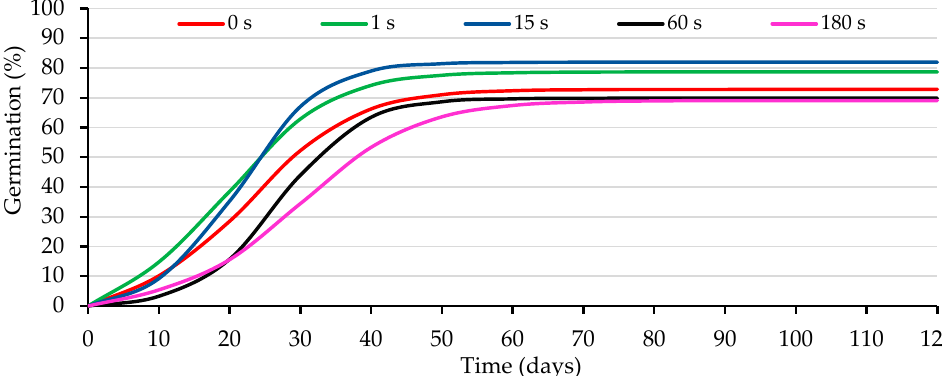
Figure 3. Logistic model adjusted to the curves of accumulated germination of caper seeds from Experiment 3. Average values of the He-Ne laser irradiation during 0, 1, 15, 60 and 180 s. A 500 mg L − 1 GA 3 solution was used to wet the substrate. Table 4. Effect of the He-Ne laser irradiation during 0, 1, 15, 60 and 180 s on the germination parameters: final germination percentage ( A , %), time required to reach 50% of final germination ( Gt 50 ; d), and average germination rate ( k /2; d − 1 ); average values from Experiment 3. A 500 mg L − 1 GA 3 solution was used to wet the substrate.